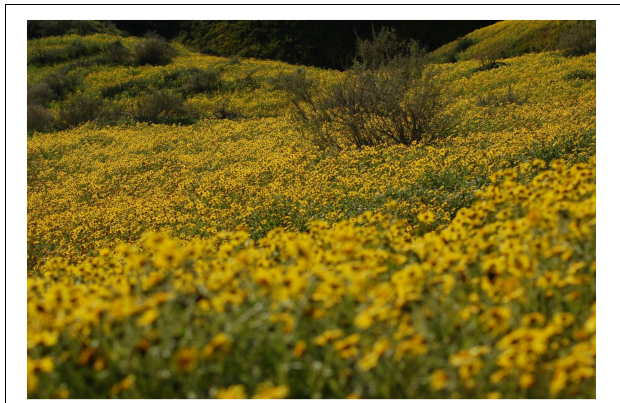
FIGURE 4 | Wildflower superbloom in Southern California, March 2020 (Photo by Tim Caro).